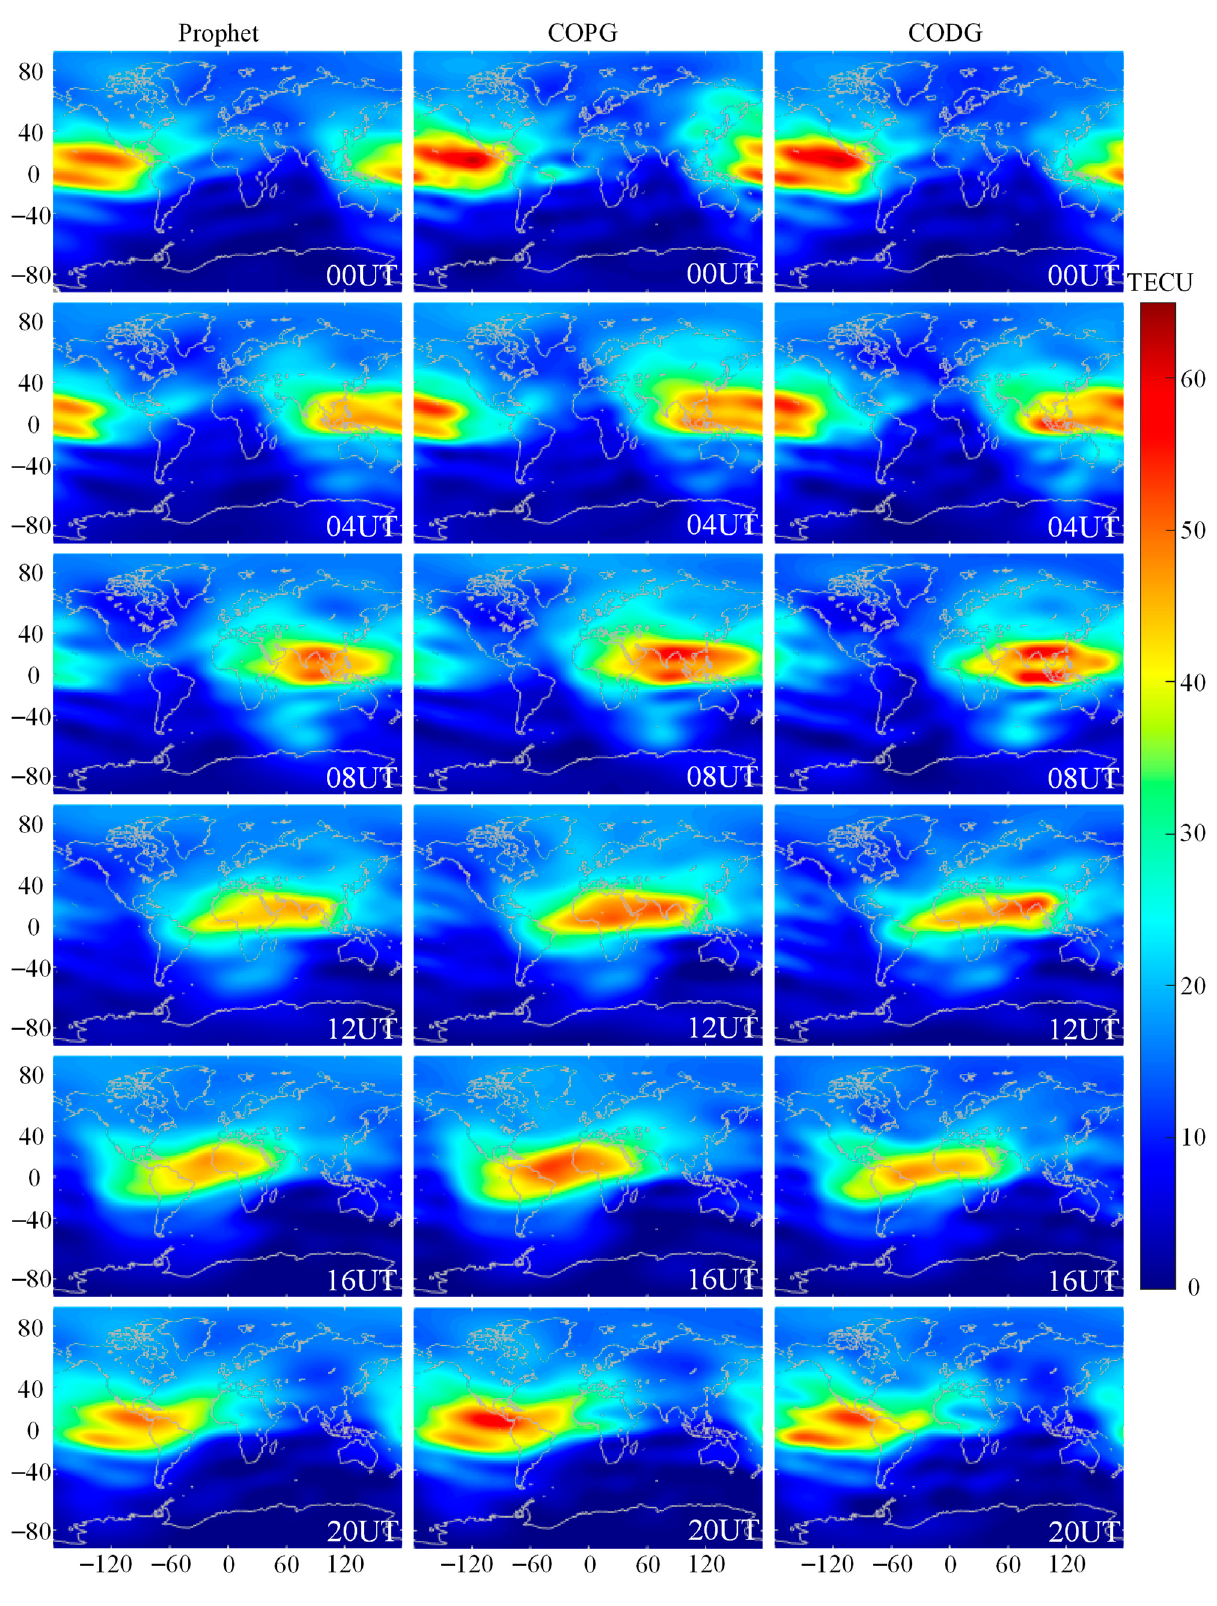
Figure 7. Comparison of Prophet model forecasted, COPG, and CODG values on 1 June 2015, at 4-h intervals under high solar activity. The first column shows the Prophet model forecasted values, the second column shows the COPG values, and the third column shows the CODG values. The horizontal axis is longitude, and the vertical axis is latitude.